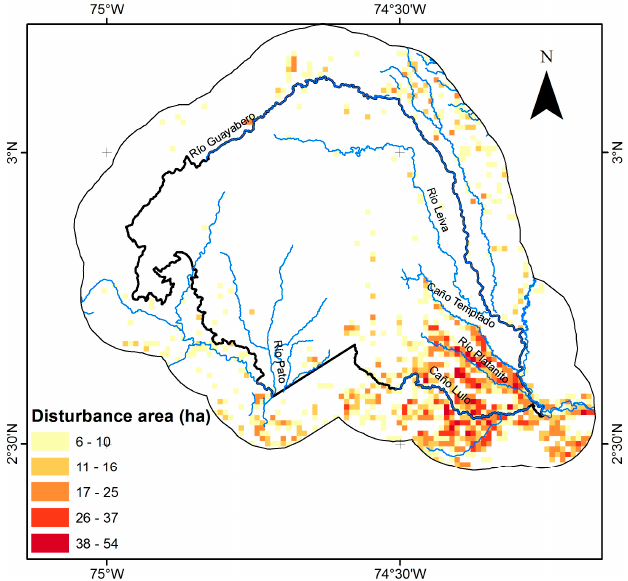
Figure 5. Cumulative BFAST monitor-derived disturbance based on the Landsat 2001–2015 time series, aggregated to 1 km pixel size for display.